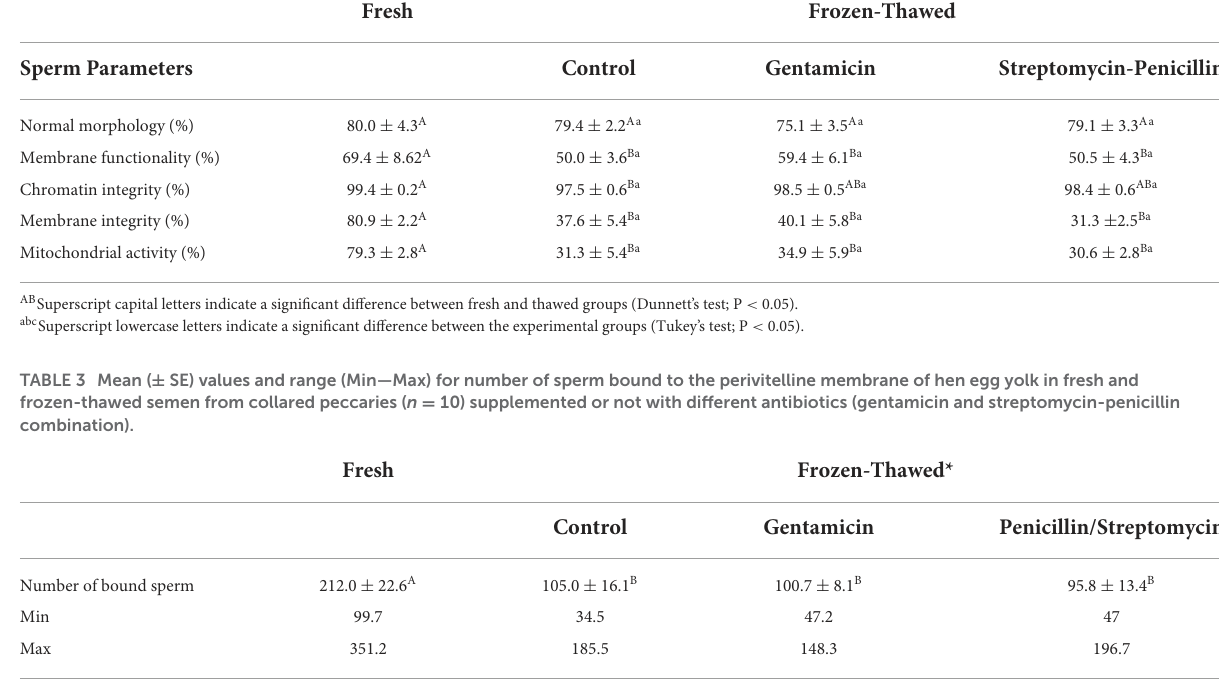
TABLE 2 Mean ( ± SE) values for sperm normal morphology, membrane functionality and integrity, mitochondrial activity and chromatin integrity in fresh and frozen-thawed semen from collared peccaries ( n = 10) supplemented or not with different antibiotics (gentamicin and streptomycin-penicillin combination).